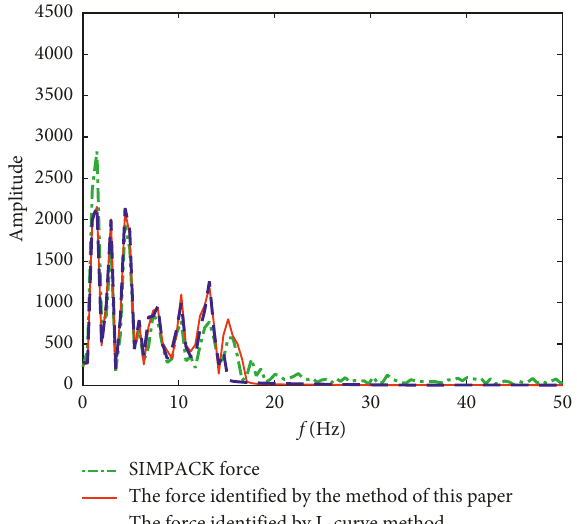
Figure 39: Amplitude-frequency curve of the two methods for F 2 identification when the noise level is Table 6: Comparison of the calculation results for F 2 obtained using the L-curve method and the proposed method. F 2 recognition results (German high-interference spectrum)